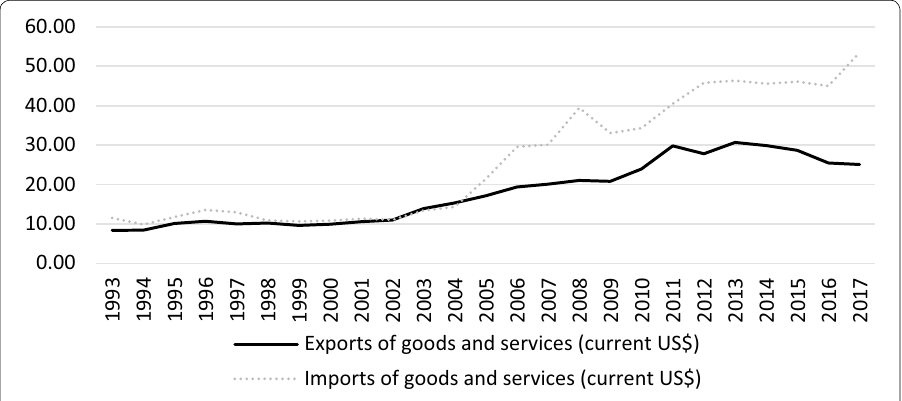
Fig. 1 Pakistan’s trade flow (source: World Bank